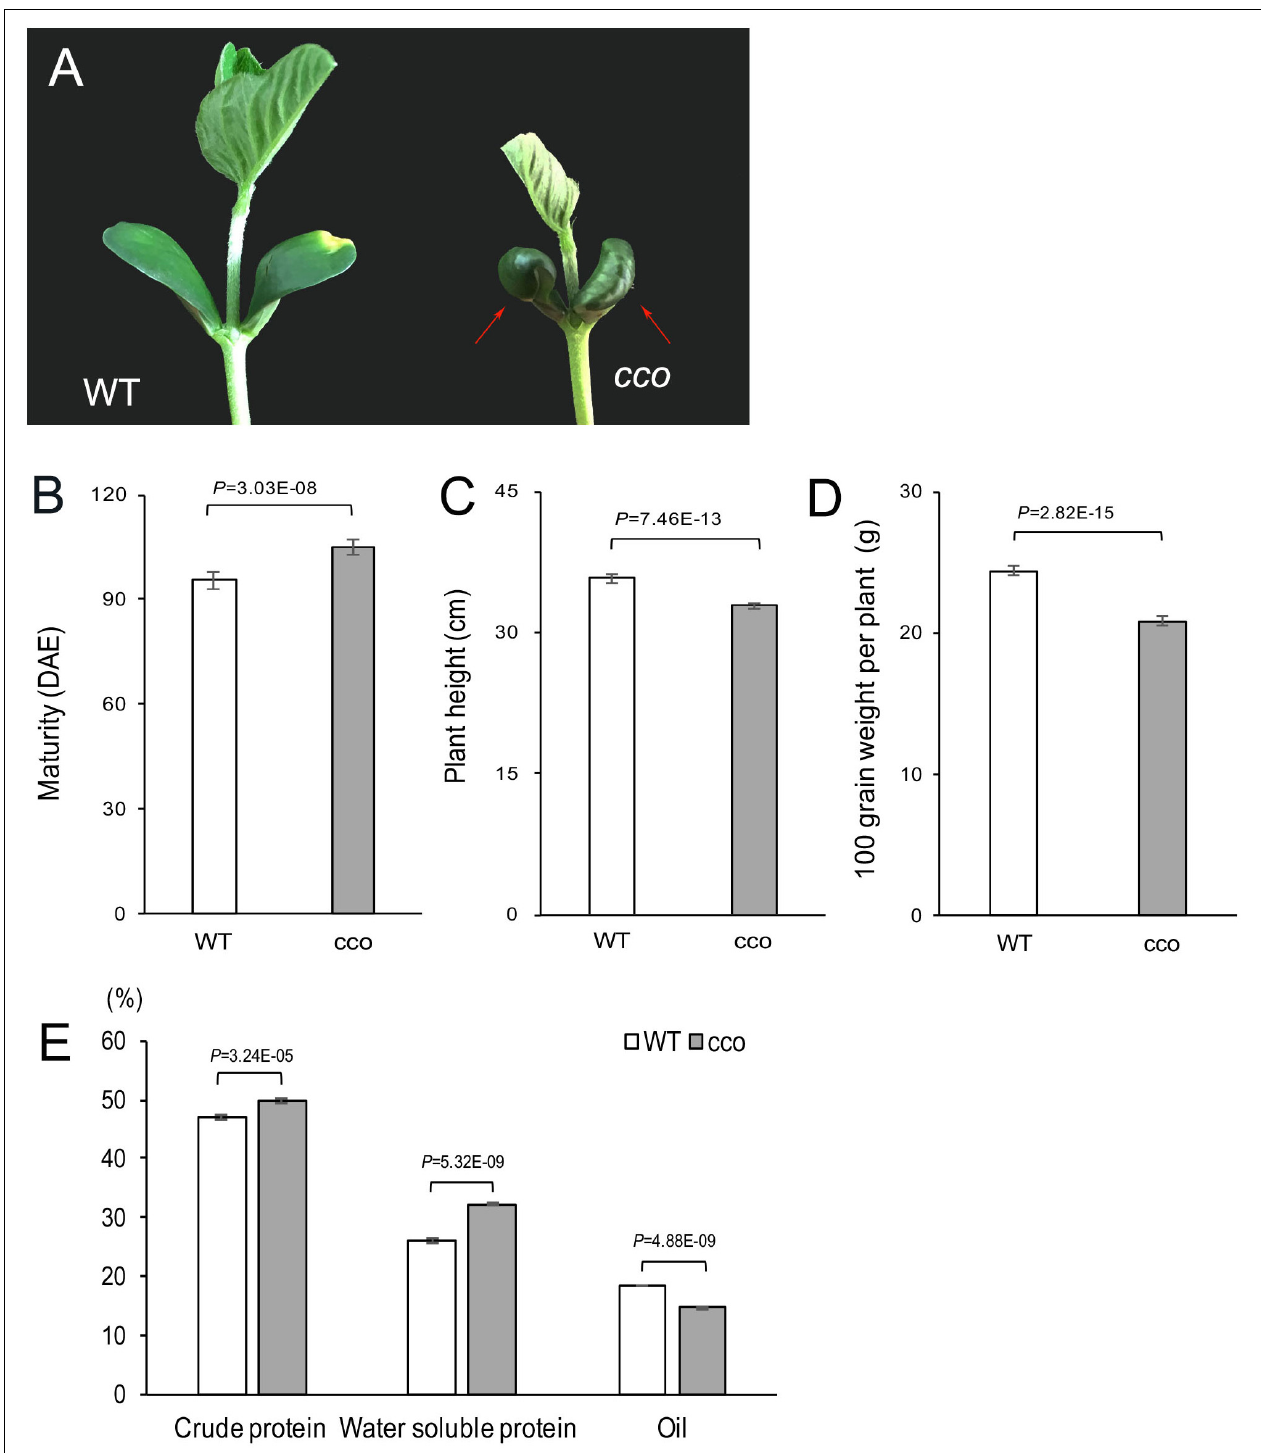
FIGURE 1 | Phenotypic characterization of the soybean cco mutant and the WT. (A) Cotyledon morphology of 6-day-old seedlings; red arrows indicate curled cotyledons in the cco mutant. (B) Days to maturity of the WT and the cco mutant. Maturity was investigated at the R8 stage (days from emergence to 95% of pods attaining mature color); DAE, days after emergence. (C) Statistics of plant height at maturity stage. (D) Comparison of 100-grain weight per plant between the WT and the cco mutant. (E) Protein and oil contents in the WT and the cco mutant; the measurement was conducted with a near-infrared seed analyzer. Plants were grown in the field with natural long-day conditions. All data are shown as means ± SD ( n = 10 plants). Two-tailed, paired-sample t -tests were used to generate the p -Values.